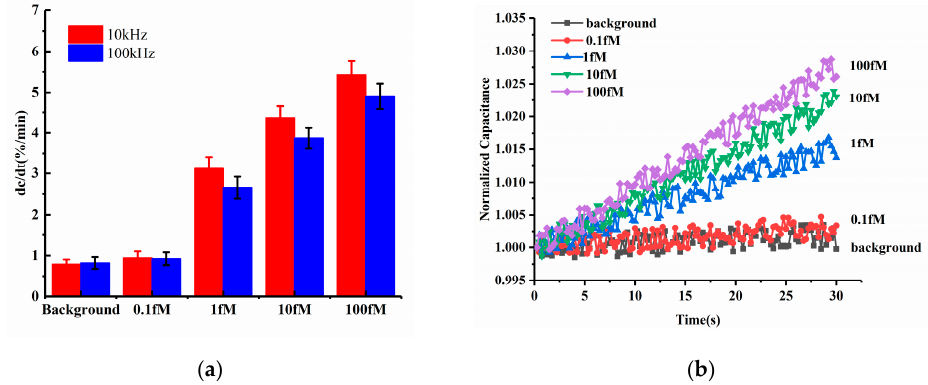
Figure 4. ( a ) Detection results at 100 kHz and 10 kHz ( b ) Normalized capacitance change as a func ‐ tion of time within 30 s for various levels of miRNA ‐ 16b.